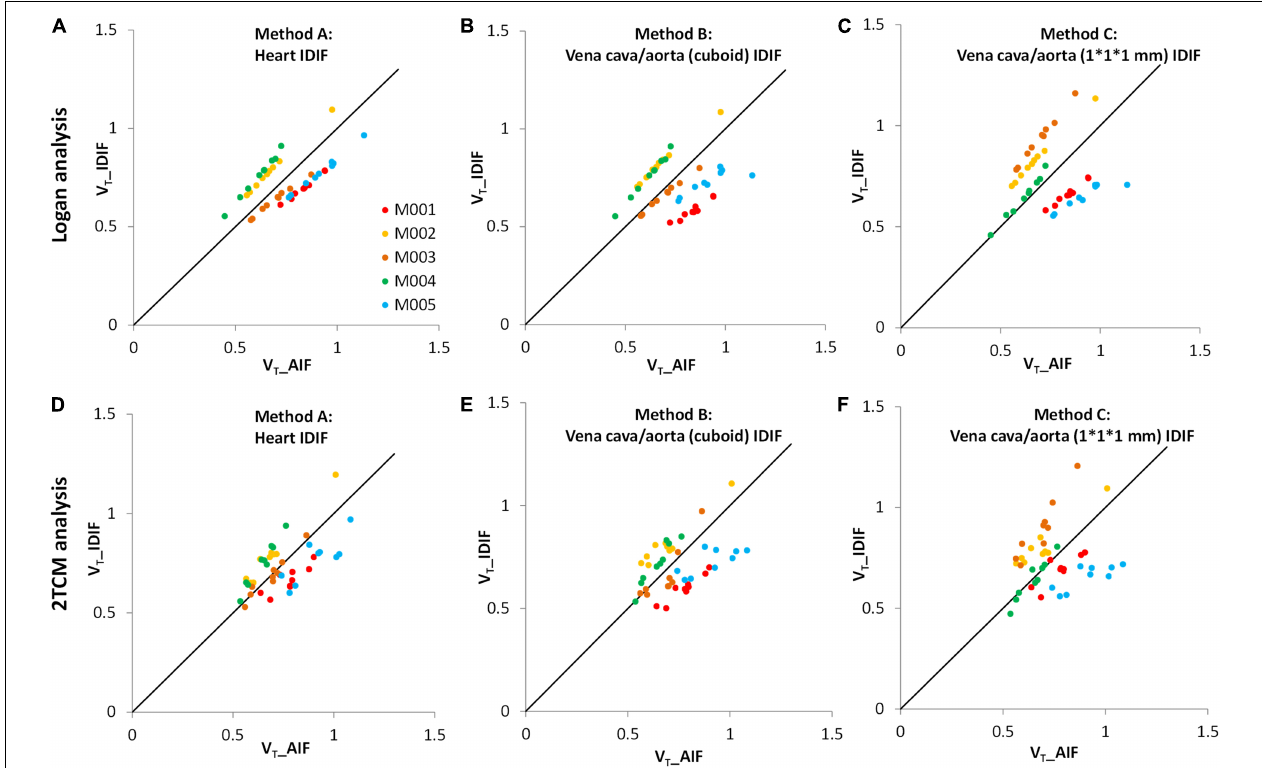
FIGURE 3 | Comparison of distribution volumes ( V T ) values between image-derived input function (IDIF) and arterial input function (AIF). All V T values of different input functions in various brain regions were generated by two kinetic models: the Logan graphical model (upper) and the 2TCM model (lower). (A,D) The IDIF with the volume of interest (VOI) placed over the heart (method A); (B,E) the IDIF with the VOI set over abdominal vena cava/aorta region with a cuboid (method B); (C,F) the IDIF with the VOI delineated with 1 × 1 × 1 mm voxels on five consecutive slices over the abdominal vena cava/aorta region (method C). Different dots represent different brain regions ( n = 9). Different colors represent different mice ( n = 5). The solid line is the line of identity.